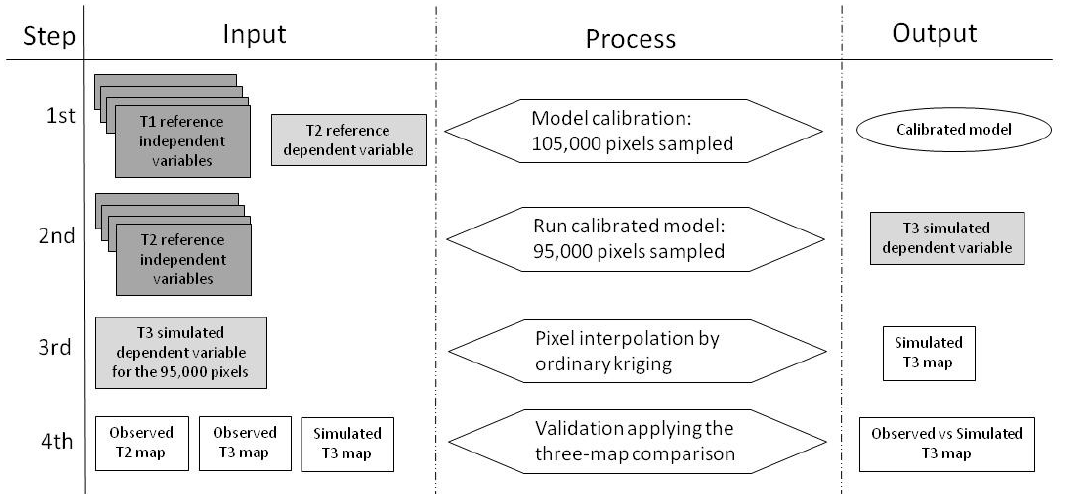
Figure 2. Summary of methods and data used in model building. The four steps were carried out twice: the first time including four and the second time 10 reference independent variables. Dark grey squares represent independent variable maps, light grey squares represent dependent variables, and white squares are maps of forest cover and forest cover change.